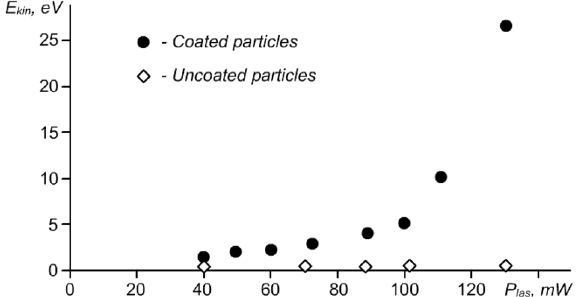
Figure 3. Kinetic energy E kin of uncoated melamine–formaldehyde (rhombus) and copper-coated melamine– formaldehyde (circles) grains vs the power P las of external laser radiation. The diameter of all grains is 9.95 μm, the pressure of buffer gas (argon) is 3 Pa, and the power of discharge is 13 W.